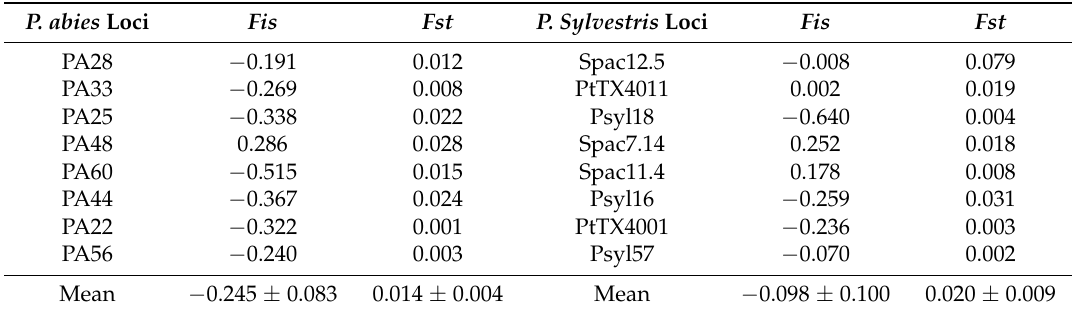
Table 3. Coefficients of genetic variation calculated for eight microsatellite loci of Norway spruce ( Picea abies (L.) H. Karst) and Scots pine ( Pinus sylvestris L.). P. abies